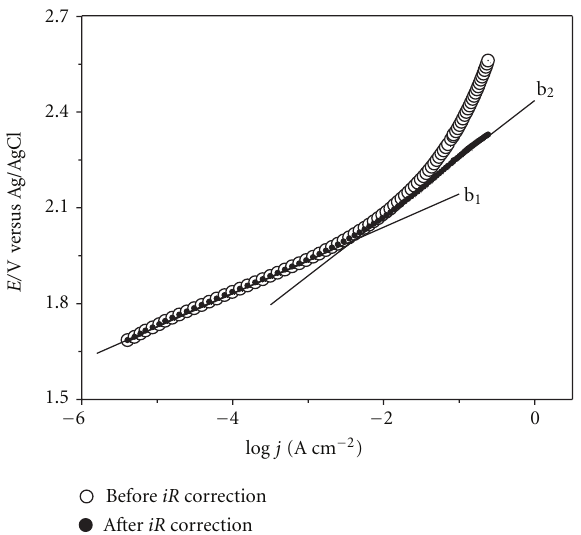
Figure 7: Typical Tafel curves for the Ti/SnO 2 -Sb-Ni electrode with Sn:Sb:Ni of 100:2:0.2 before and after iR correction in 0.1 M H 2 SO 4 solution at 25 ± 1 ◦ C. scan rate: 1mVs − 1 .